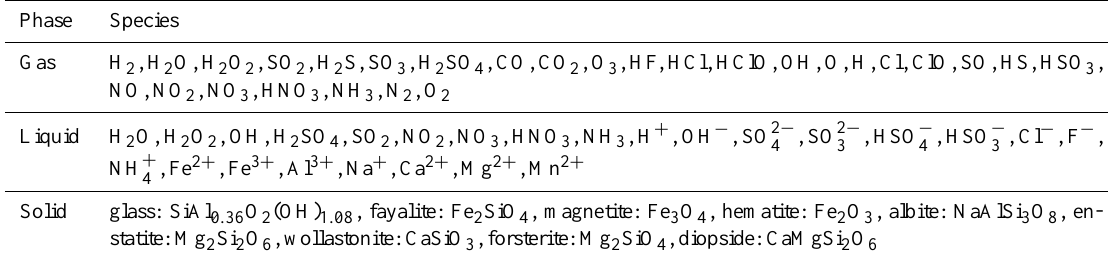
Table 2. The major species considered in this study. Phase